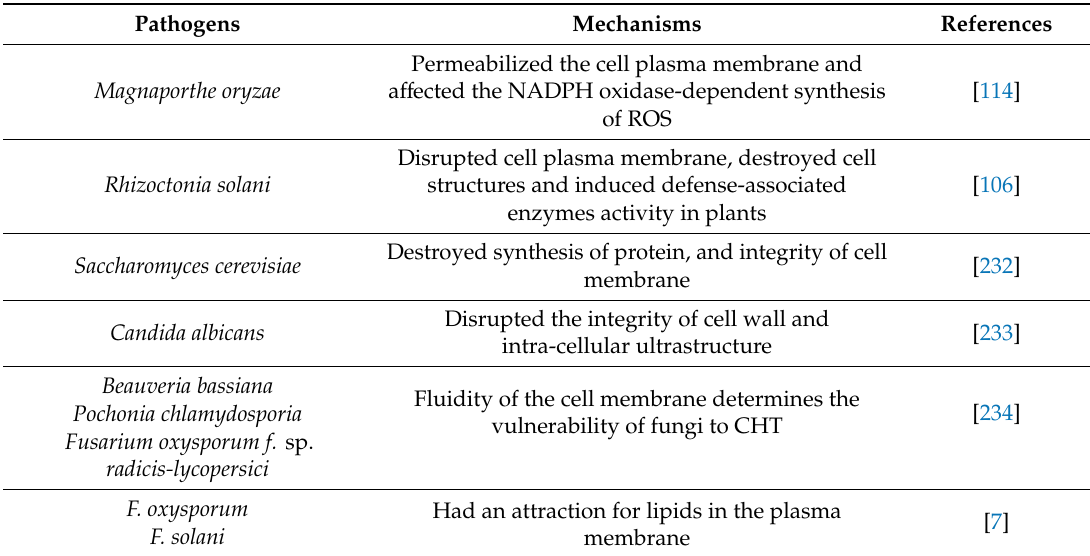
Table 6. Proposed antimicrobial mechanisms of